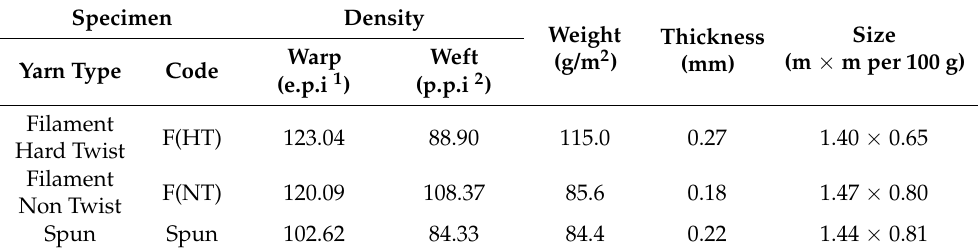
Table 1. Characteristics of